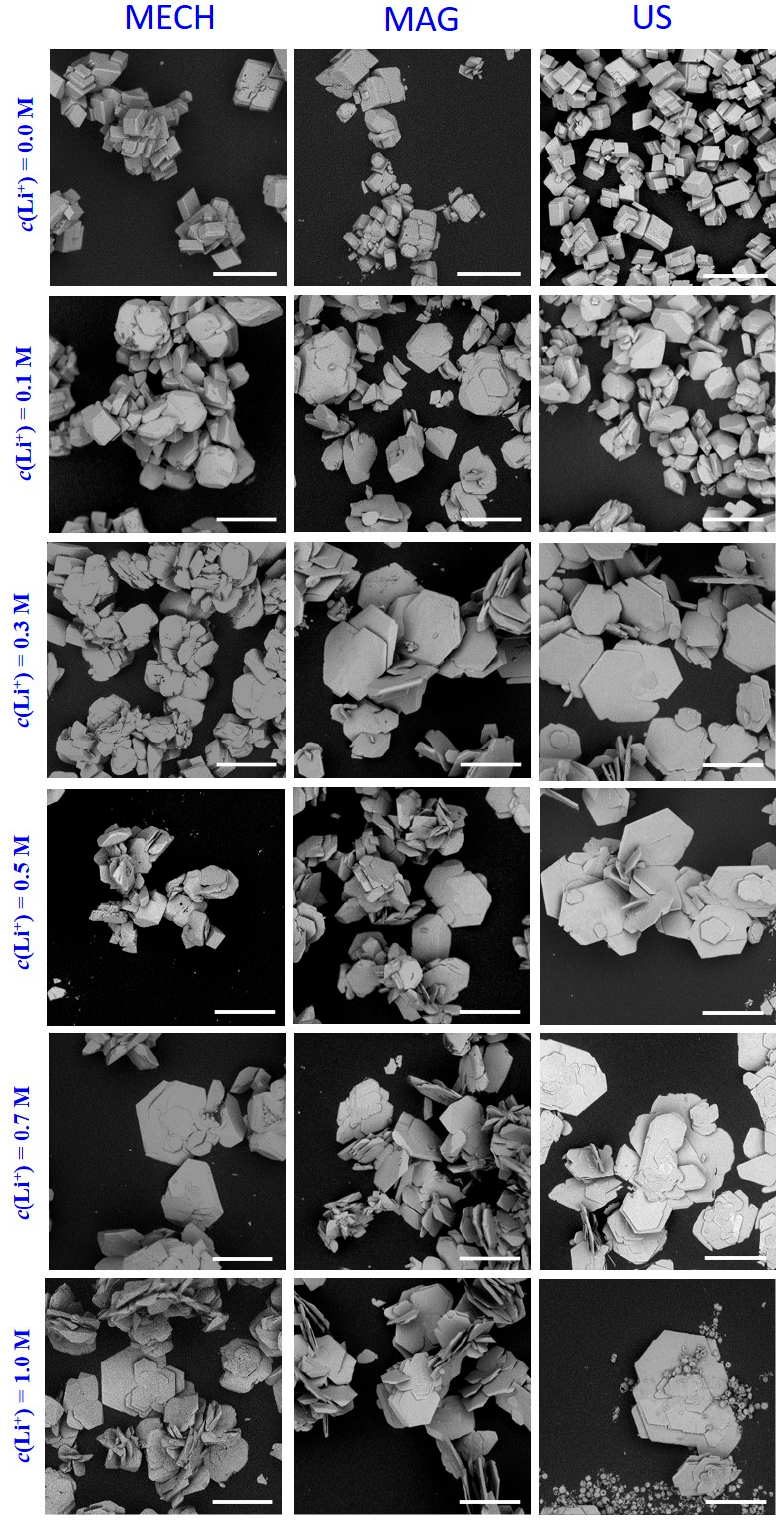
Figure 3. Morphologies of precipitates isolated after 5 days of aging in the systems with different initial stirring modes (MAG—magnetic, MECH—mechanical, US—ultrasonic irradiation) and different initial Li + concentrations, determined by SEM. Scale bars correspond to 30 µm.